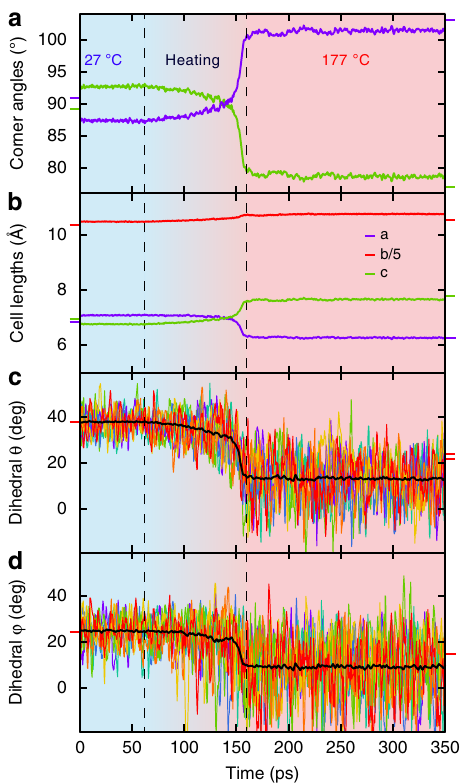
(ps)0 50 Time Fig. 4 Molecular dynamics simulations. Molecular dynamic simulations show that the molecular con fi guration rearrangement by rotations of the dihedral angles ( c , d ) is accompanied by a change in cell dimensions ( b ) and crystal corner angle ( a ). Colored lines in the panels c and d correspond to a few individual molecules; one from each layer in the simulation cell. The black line follows the average over all 512 molecules (1024 dihedrals). The vertical dashed lines indicate the times at which the temperature in the simulation is changed from 27 °C via a linear ramp (between 60 and 160 ps) to 177 °C. The background colors visualize this temperature increase from blue to red. The outside colored short lines on the left and right borders of the graphs are the corresponding experimental values of the α - phase (at 27 °C) and β -phase (at 177 °C), respectively. Cooling the thus obtained structure to 27 °C shows that the energy of this new form is higher than that of the α -phase at the same temperature, making it indeed a reversible transition driven by entropy. Source data are provided as a Source Data fi